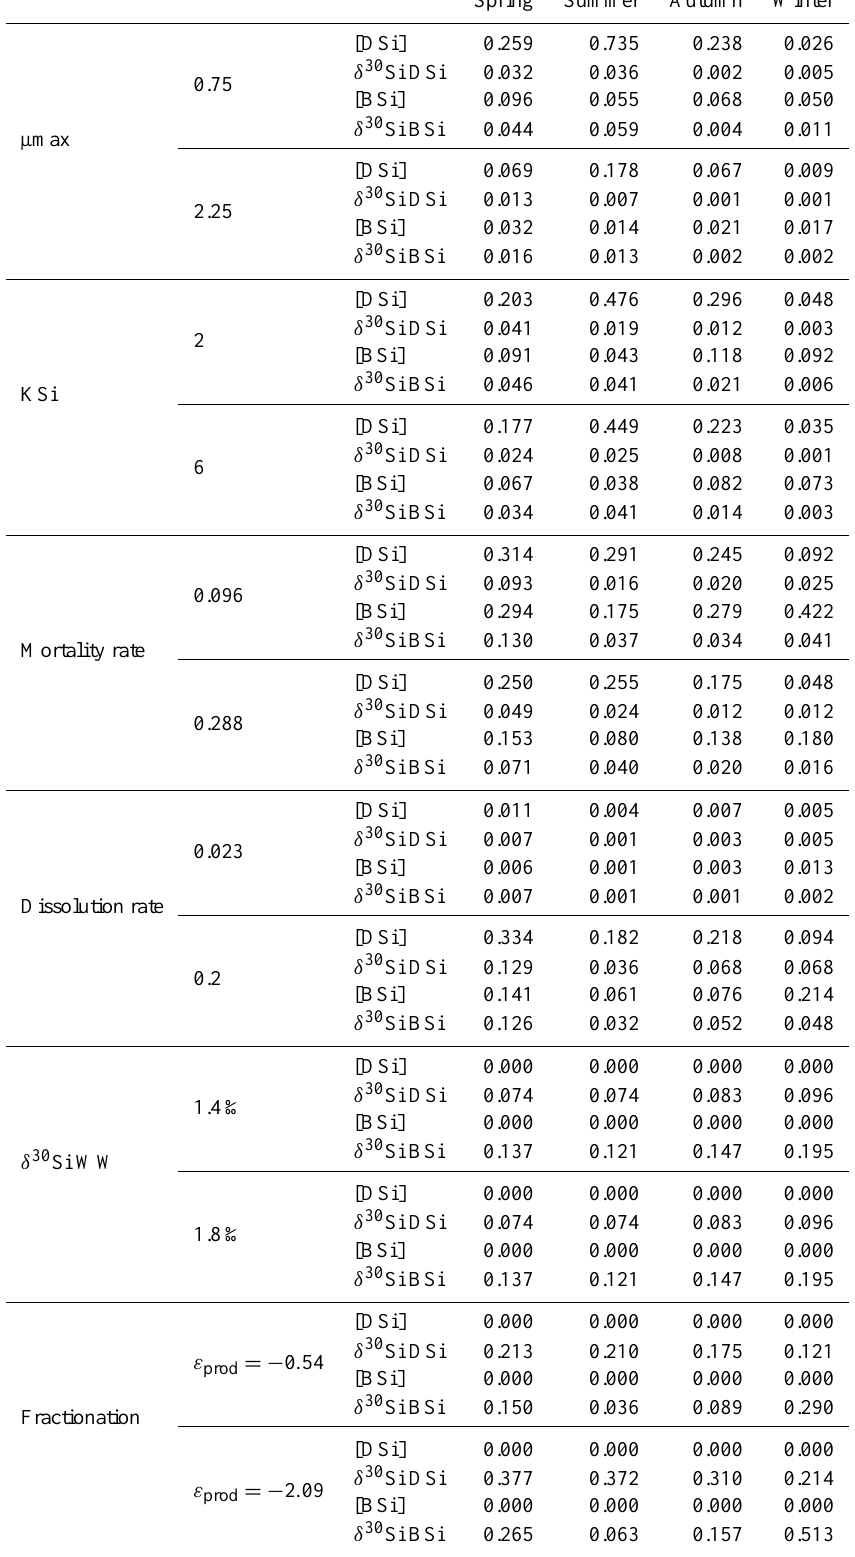
Table 4. Sensitivity index (SI) per season for coefficients tested; SI varies from 0 (0%) to 1 (100%).